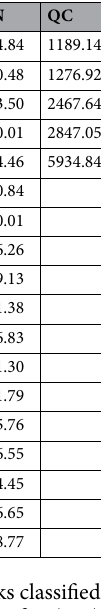
Table 2. Peaks classified as discriminative using genetic algorithm (GA), supervised neural network (SNN) and quick classifier (QC).